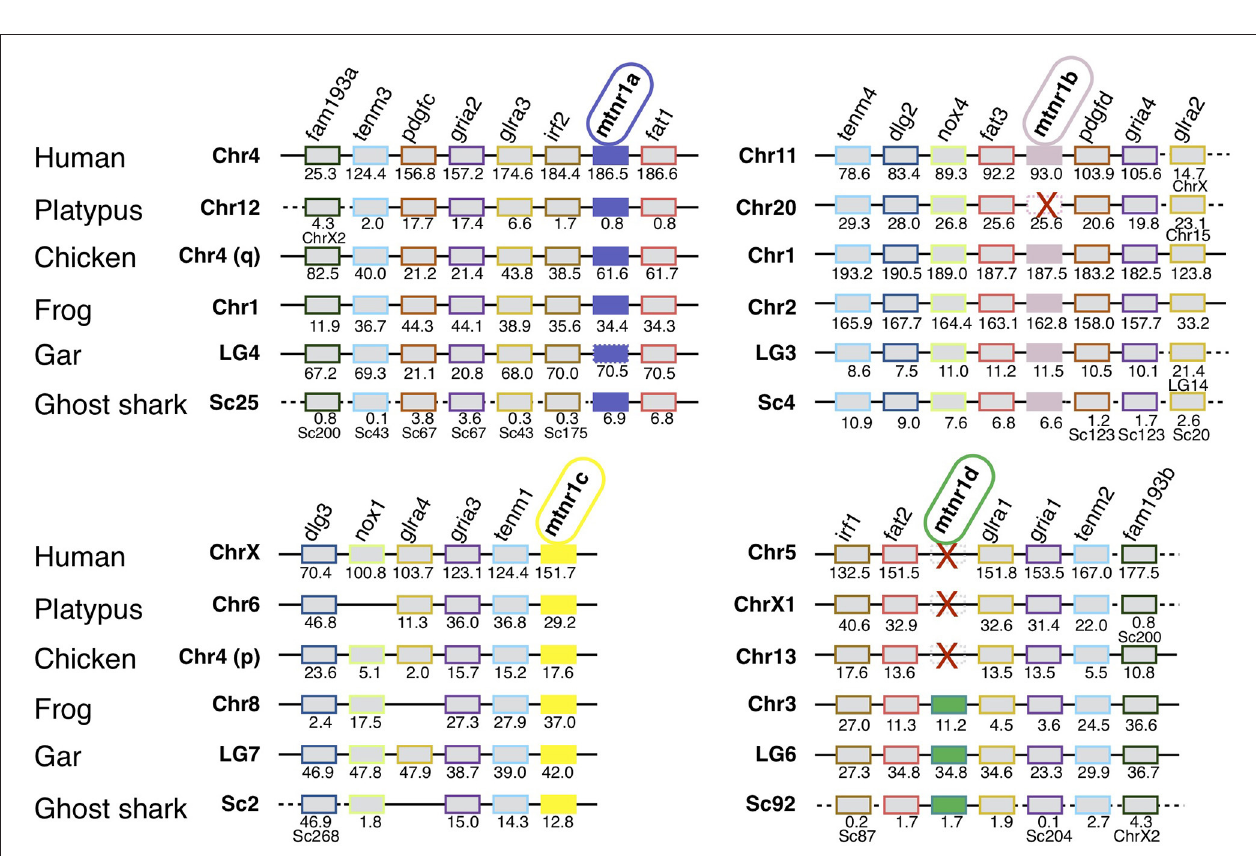
FIGURE 3 | Conserved syntenic regions of melatonin receptors in gnathostomes. Locations are given in Mb. Gene order follows that of the human chromosomes 4, 5, 11, and X. Each neighboring gene family is displayed with a specific color. Red crosses indicate mtnr gene loss. In the spotted gar, the mtnr1a was found as pseudogene in the genome assembly but a transcript encoding a functional receptor was found in the PhyloFish database. We assumed that the mtnr1a pseudogene form results from an assembly error, and therefore the mtnr1a is represented by the mtnr1a blue box, but with the perimeter edges dotted. The new gene locations in the genome assembly are indicated under the gene position. Full names and references of mtnr and neighboring genes are given in Supplementary Table 2